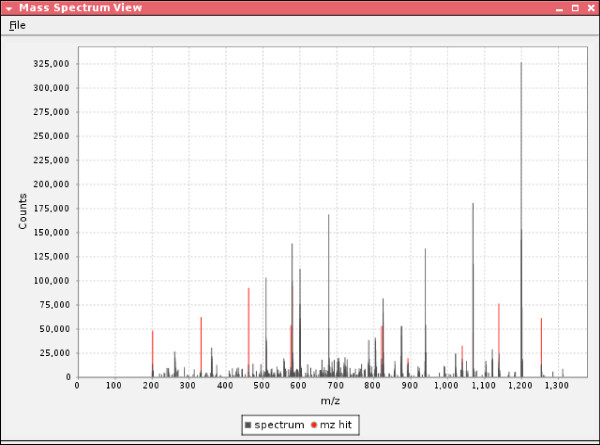
OMSSA mass spectrum view.